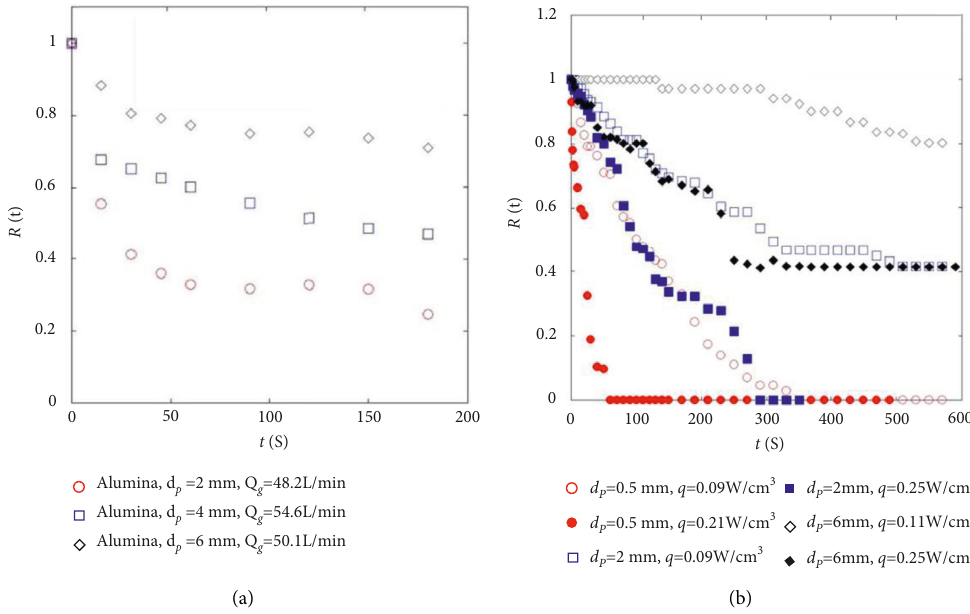
Figure 12: Effects of typical parameters on self-leveling development (spherical alumina particle) [10, 32, 36] (a) Effects of particle size (gas- injection condition) (b) Effects of bubbling rate (boiling